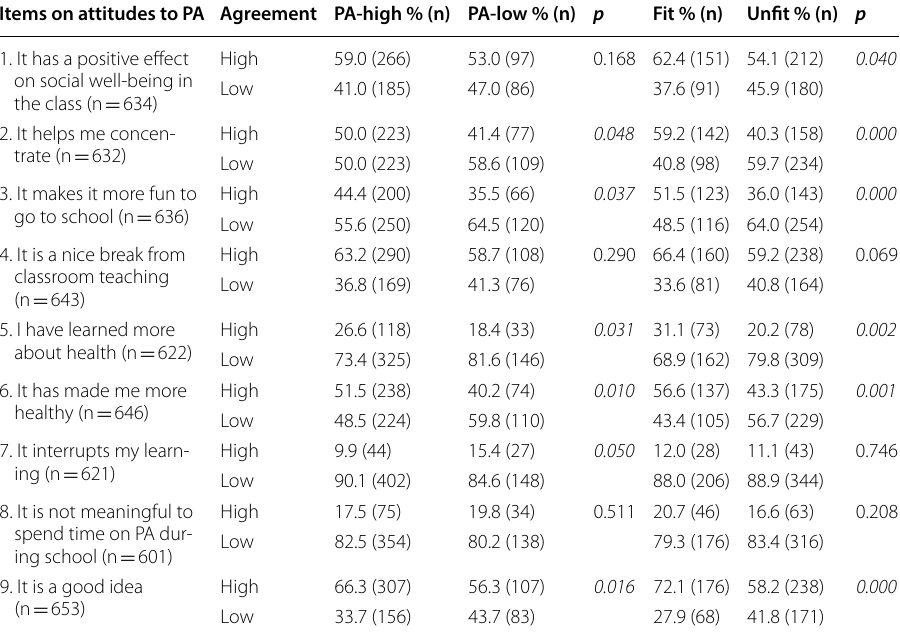
Italic values are statistically significant (p